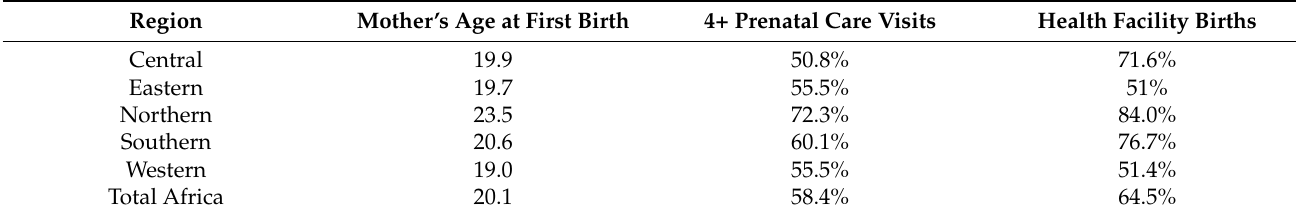
Table 4. Mother’s age at first birth, prenatal visits, and birth at a health facility by